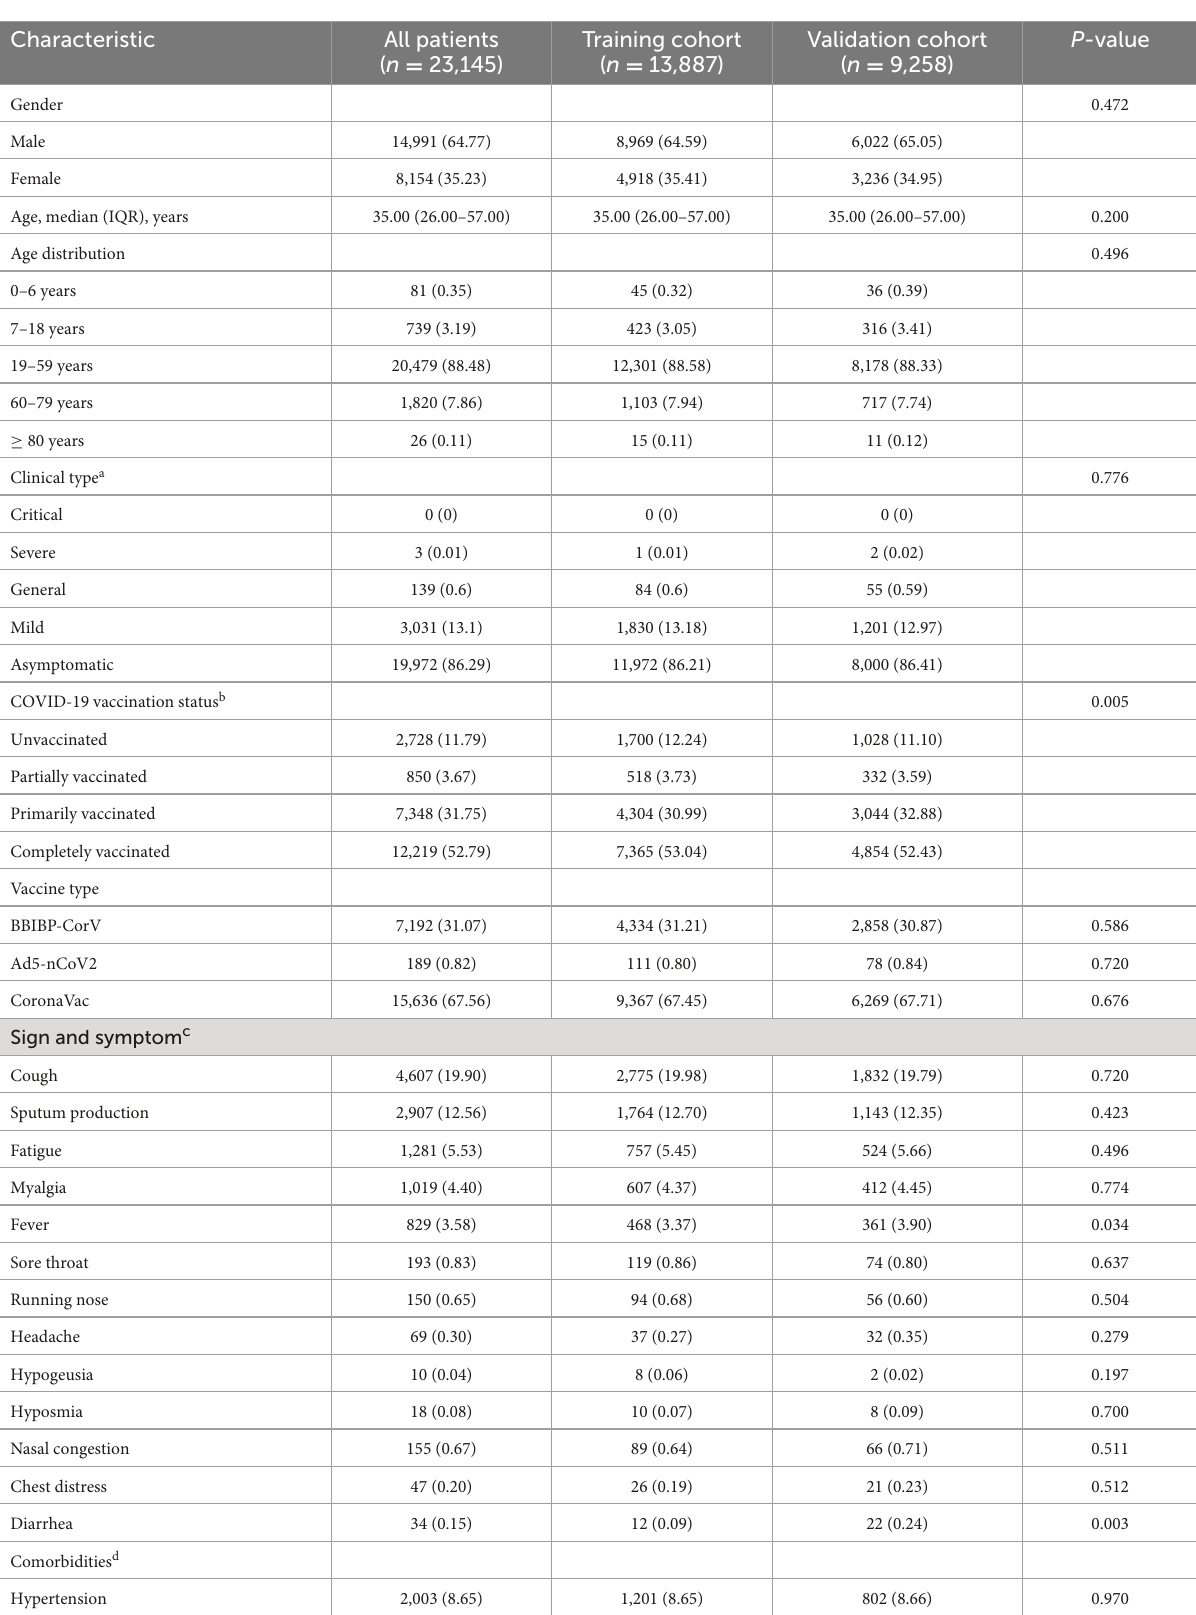
TABLE 1 Baseline characteristics of the study